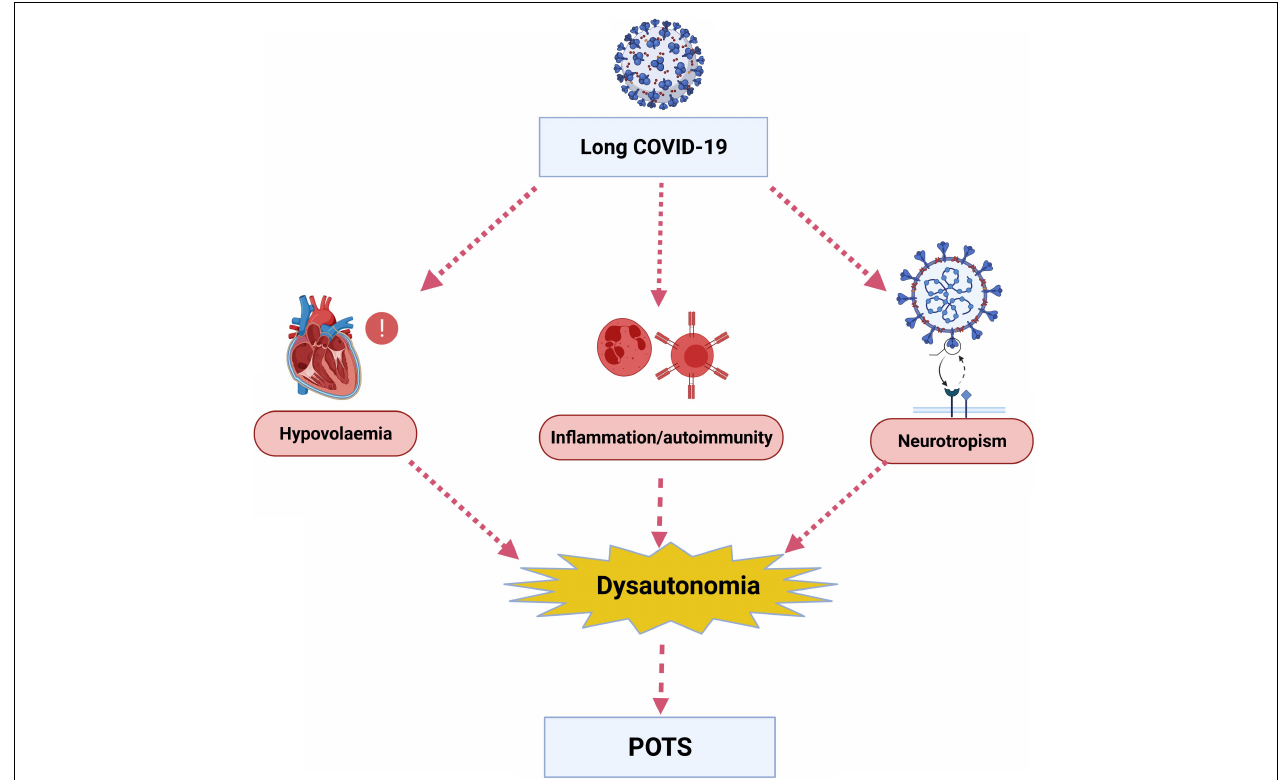
FIGURE 1 | Potential underlying mechanisms by which long COVID leads to dysautonomia and postural orthostatic tachycardia syndrome (POTS). (Created with